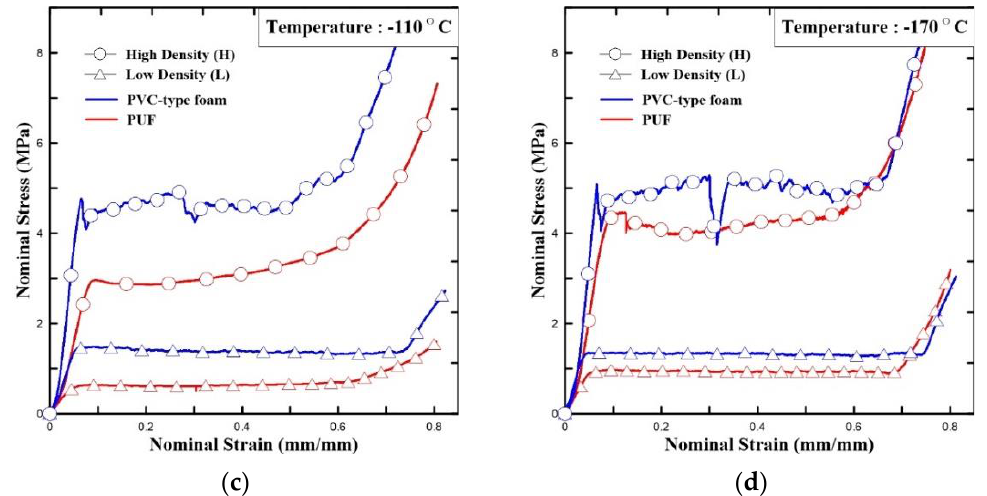
Figure 10. Stress – strain curve of the PUF(H, L) and PVC-type foam(H, L) at different temperatures: ( a ) 20 °C, ( b ) −50 °C, ( c ) −110 °C, and ( d ) −170 °C (compressive test). Table 7. Test results of compressive Young’s modulus and yield stress.